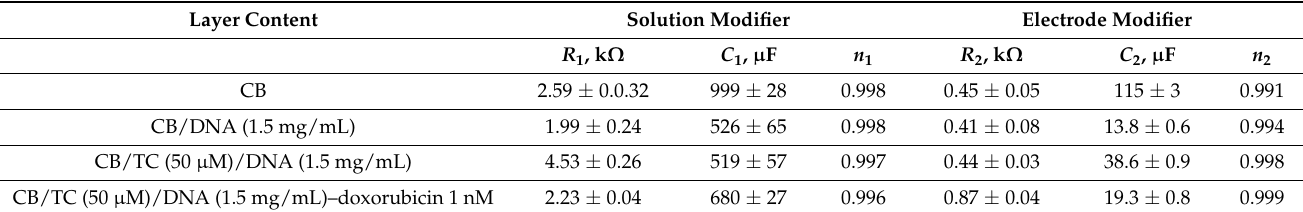
Table 1. EIS parameters corresponded to various steps of the surface layer assembling (average ± S.D., four